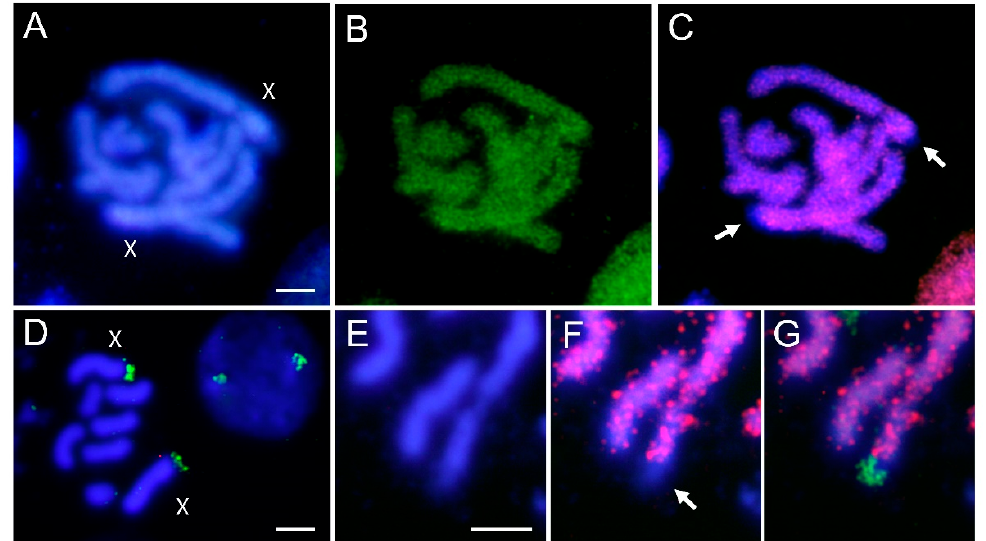
Figure 2. ( A ) Mitotic chromosomes of A. fabae after DAPI staining, ( B ) the same metaphase after FISH with biotin-labelled Afabmar-Mr as a probe, and ( C ) merged image. ( D ) Chromosomal localization of rDNA sites, using biotin-labelled rDNA as a probe, showing hybridization signals on one of the terminal regions of both X chromosomes (green). ( E ) Selected chromosome X after DAPI staining, ( F ) FISH with biotin-labelled Afabmar-Mr as a probe (red), and ( G ) digoxigenin-labelled rDNA as a probe (green). Arrows indicate the terminal DAPI negative region of the X chromosomes where is located the nucleolar organizing region. Bar =10 μ m.